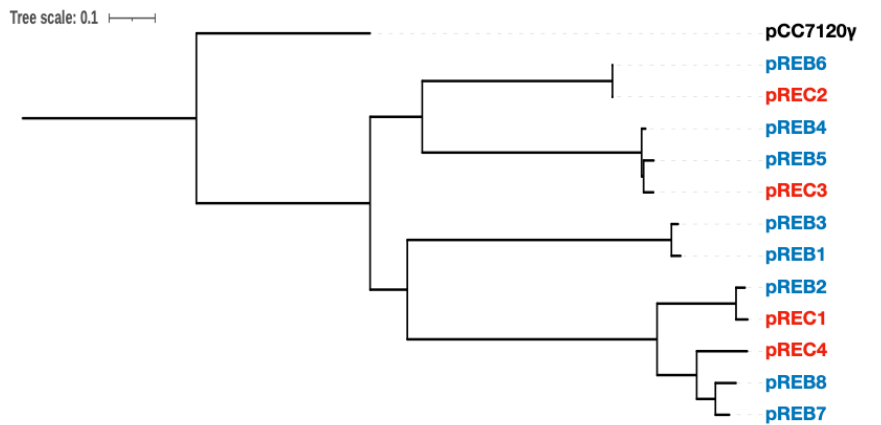
Figure 6. Phylogenetic relationship of each plasmid based on relaxase gene homology. The phylo- genetic relationship of each plasmid was classified on the basis of the amino acid sequence of the relaxase (MobF) protein encoded in each plasmid. The plasmids shown in red are from A. marina MBIC10699, and the plasmids shown in blue are from A. marina MBIC11017. MobF encoded by pCC7120γ (black), the plasmid from Anabaena sp. strain PCC7120, was used as the outgroup.